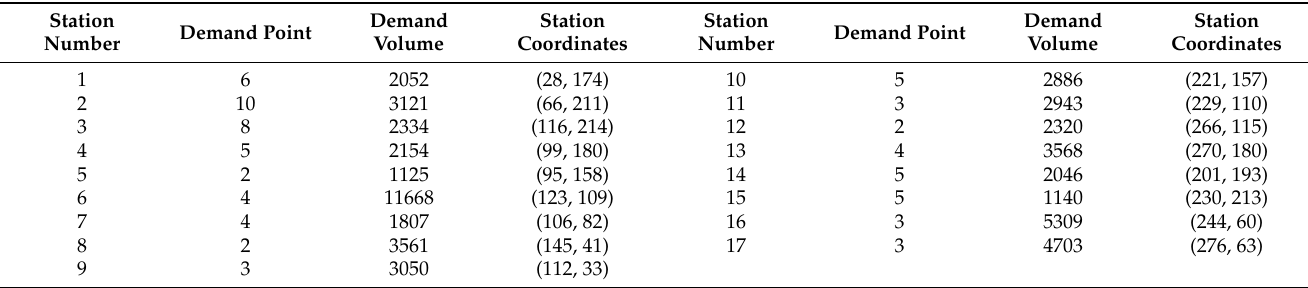
Table 7. Location results of parcel-receiving